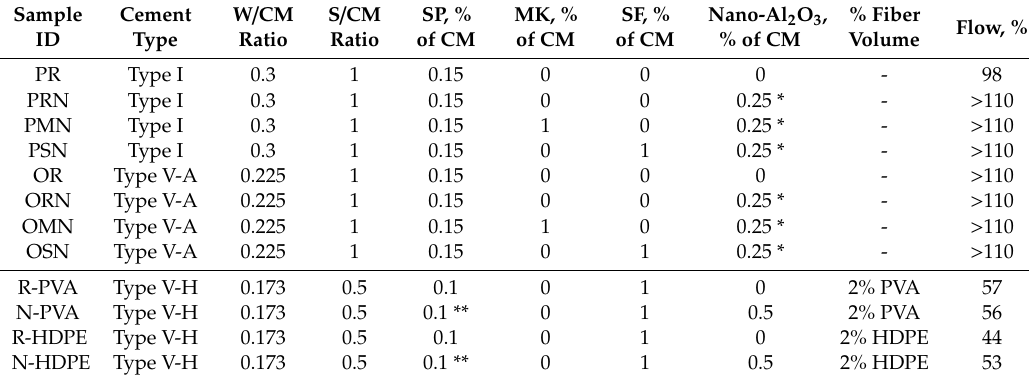
Table 2. Experimental matrix for fiber-reinforced cement-based composites (FRC) with Al 2 O 3